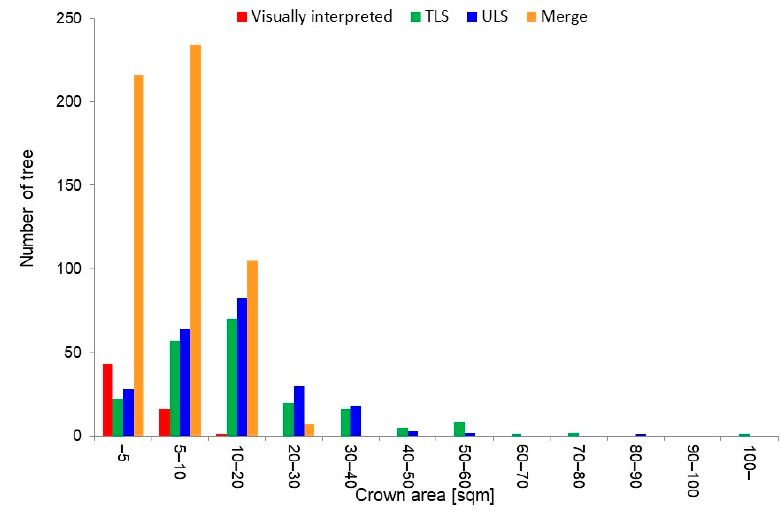
Remote Sens. 2023 , 15 , x FOR PEER REVIEW Figure 7. Distribution of canopy area identified through tree segmentation. Figure 7. Distribution of canopy area identified through tree segmentation.